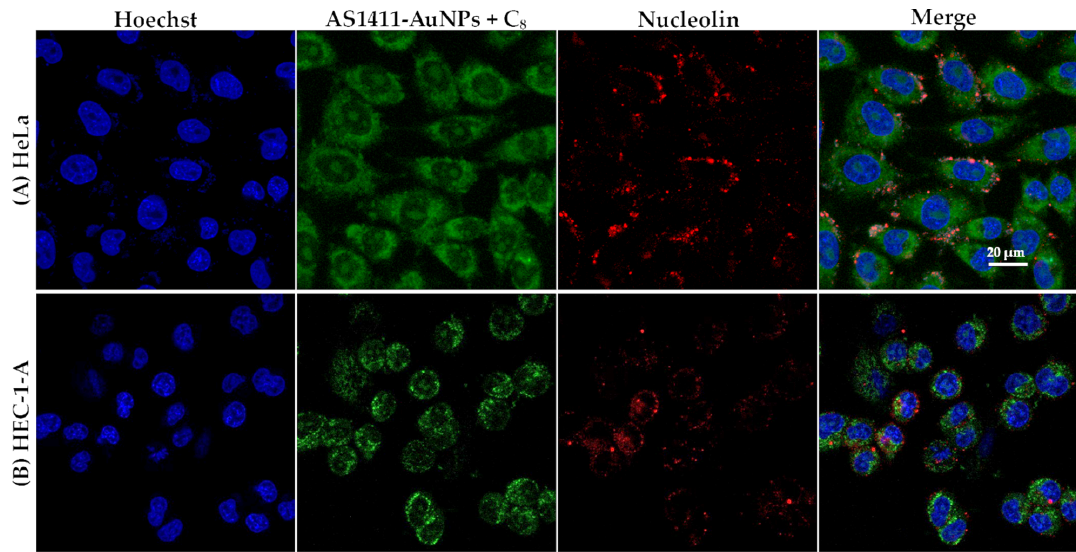
Figure 6. Confocal fluorescence images of ( A ) HeLa and ( B ) HEC-1-A cells incubated with AS1411-gold nanoparticles with C 8 for 15 min at 37 °C. Nucleolin is stained with AlexaFluor 647 ® (red), C 8 emits green fluorescence. Cell nuclei are stained with Hoechst 33342 (blue). Scale bar: 20 µm.